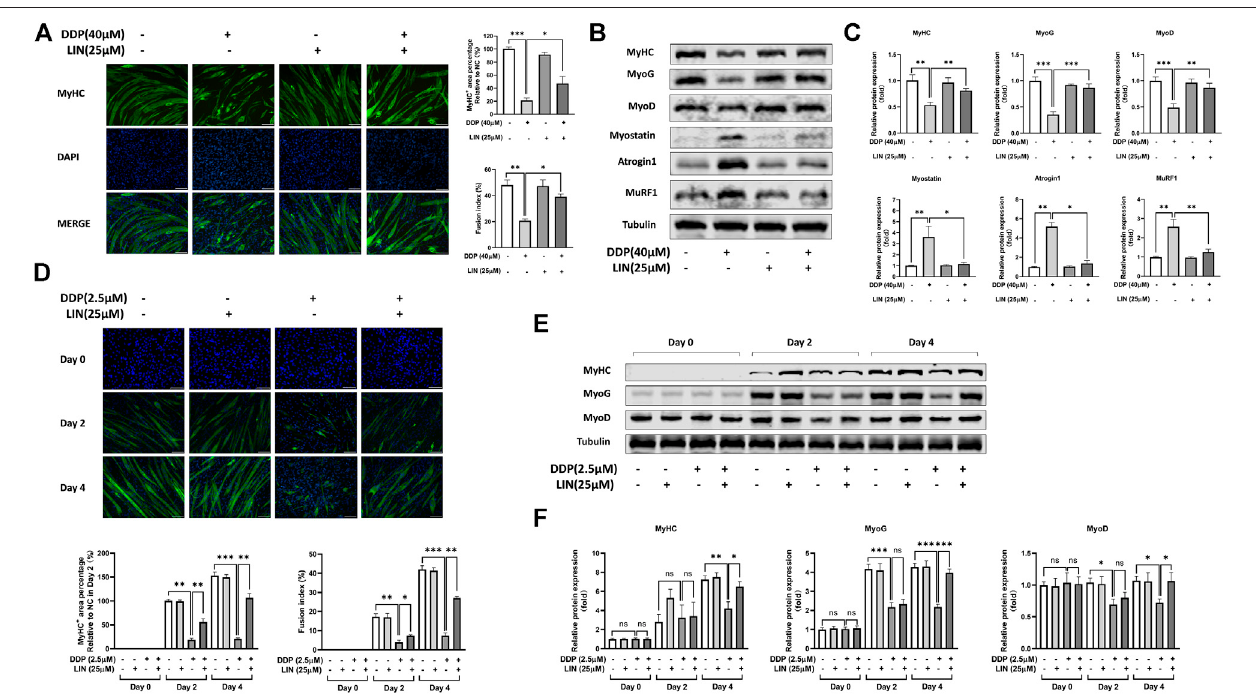
FIGURE5| EffectofLINondifferentiationandatrophyofDDPtreatedC2C12myotubes (A) TheMyHC + areaandfusionindexofC2C12myotubesweremeasured using ImageJ software (scale bars (cid:2) 100 μ m). (B) Protein expression of MyHC, MyoG, MyoD, Myostatin, Atrogin1, MuRF1 was evaluated by western blotting, Tubulin was used as an internal control. (C) The relative protein expression levels of MyHC, MyoG, MyoD, Myostatin, Atrogin1, MuRF1 were quanti fi ed using ImageJ software and normalized to Tubulin and corrected to the untreated group. (D) The MyHC + area and fusion index of C2C12 myotubes in differentiation process were measured using ImageJ software (scale bars (cid:2) 100 μ m). (E) Protein expression of MyHC, MyoG, MyoD was evaluated by western blotting, Tubulin was used as an internal control. (F) The relative protein expression levels of MyHC, MyoG, MyoD were quanti fi ed using ImageJ software and normalized to Tubulin and corrected to the untreated group. Data shown as mean ± S.E.M. (n (cid:2) 3); * p < 0.05, ** p < 0.01, *** p < 0.001.